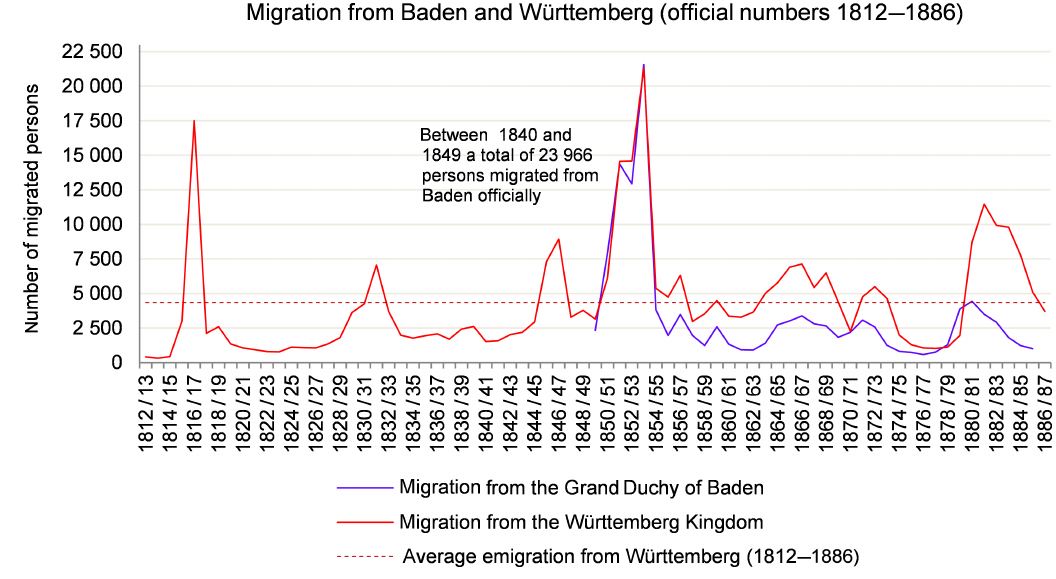
Figure 4. Official numbers of emigrants from Württemberg and Baden